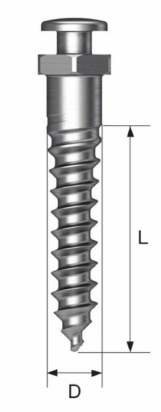
Figure 1. Schematic diagrams of the miniscrews (D—diameter, L—length, where D = 1.8 mm and L = 10